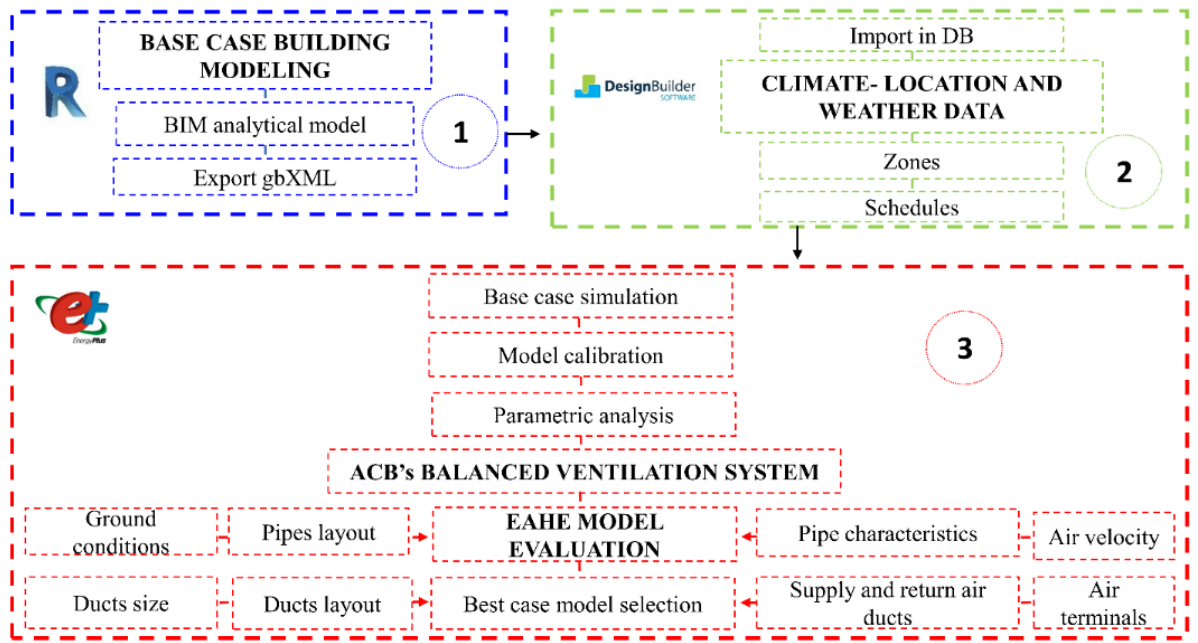
Figure 2. The modeling and analysis framework. Legend: BIM, building information modeling; gbXML, Green Building Extensible Markup Language; DB, DesignBuilder; ACB, architectural campus building; EAHE, earth-to-air heat exchanger.